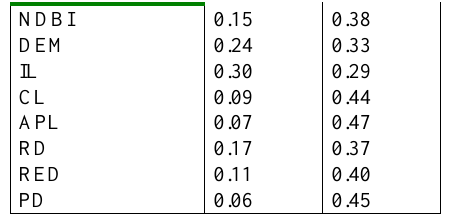
Table 5. VIMs of variables in sub-urban area of Wuhan